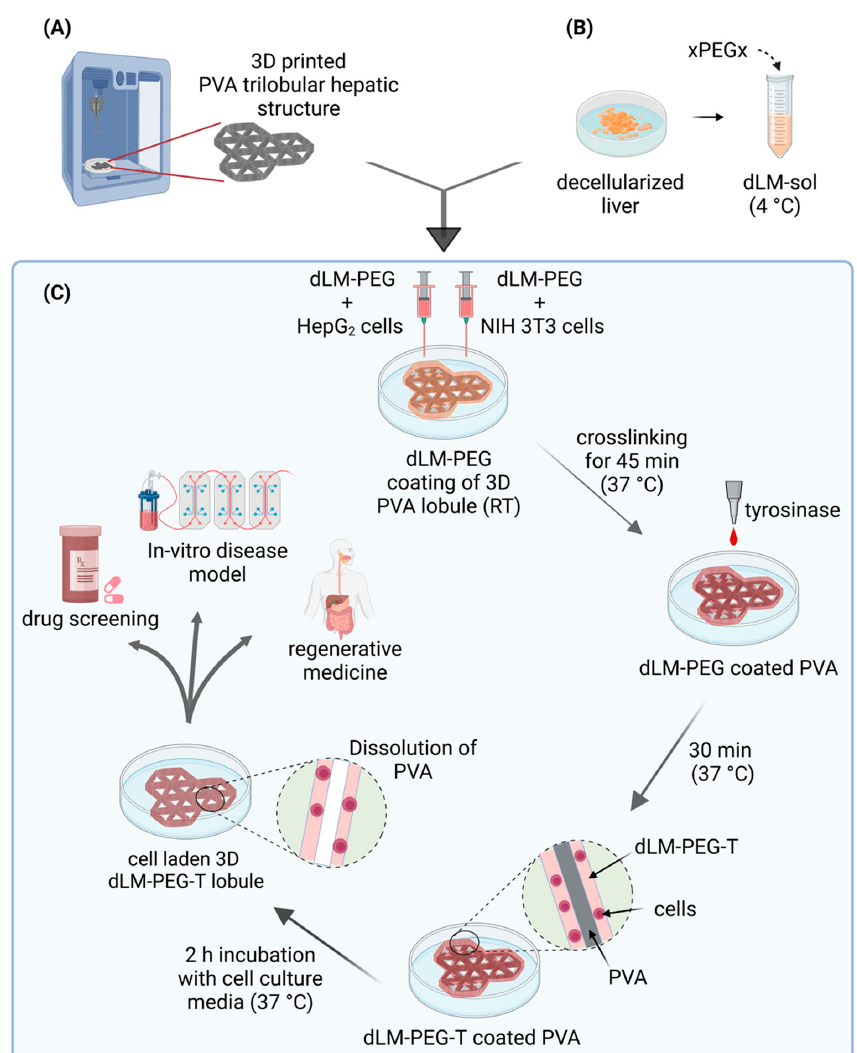
Figure 1. Schematic showing the development of dLM-PEG-T trilobular hepatic construct with indirect 3D printing of PVA. ( A ) PVA is 3D-printed into a trilobular hepatic structure, and ( B ) the dLM-sol is formed from decellularized liver tissue followed by the addition of polyethylene glycol (xPEGx, x = succinimidyl valerate). ( C ) The dLM-PEG formulations mixed with HepG 2 and NIH 3T3 cells were dispersed on PVA and crosslinked at 37 ◦ C, followed by the addition of tyrosinase to further enhance the crosslinking. The final dLM-PEG-T construct was incubated for 2 h to dissolve the PVA, leaving behind a 3D structure with lumen patency for applications in drug screening, in vitro disease models, and regenerative